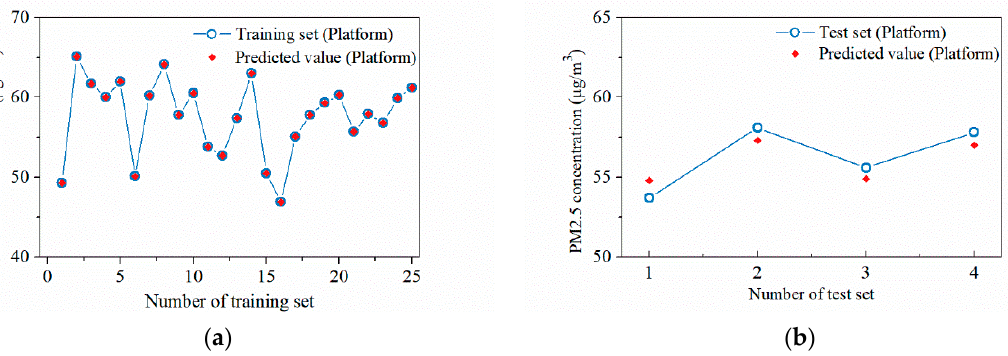
Figure 19. Regression result of the sampling points at the platform floor: ( a ) Training set; ( b ) Test set.